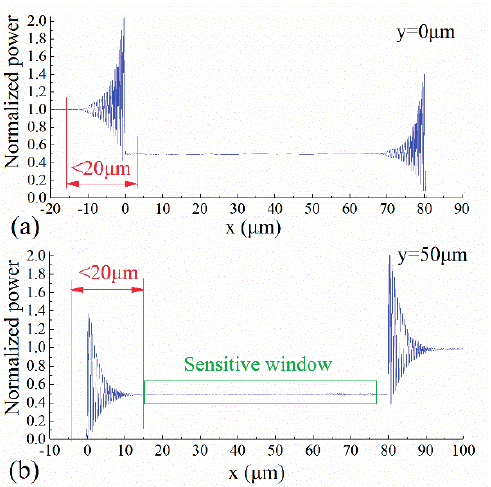
Figure 16. Normalized power of the SOI rib waveguide mode propagating along the sensing arm and the reference arm.